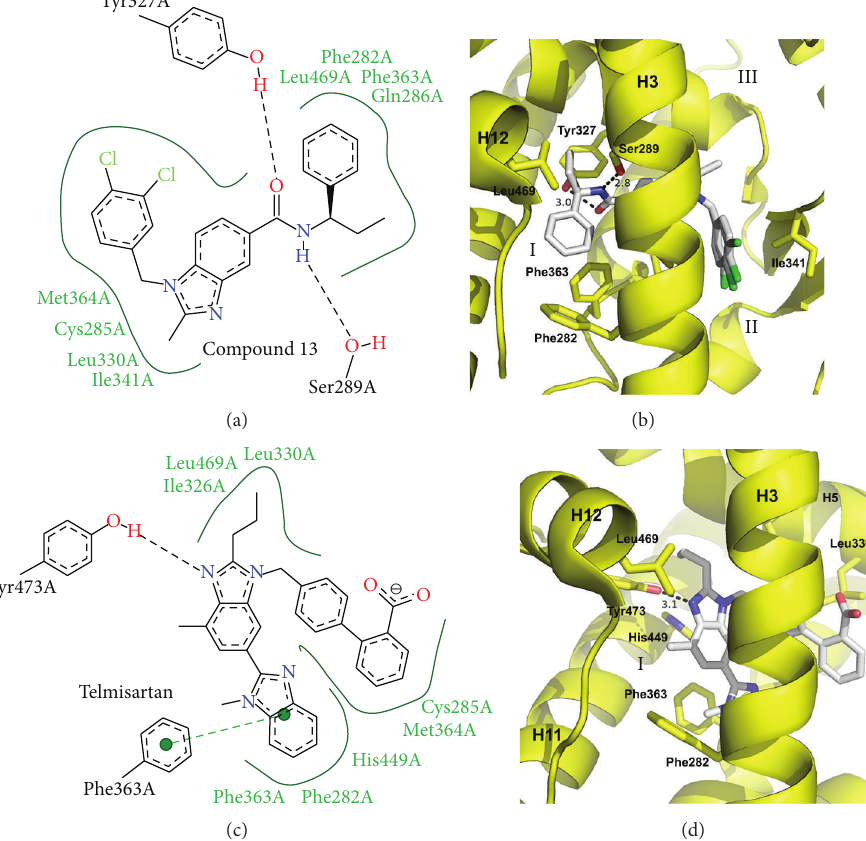
Figure 4: Crystal structures of benzimidazole containing PPAR 𝛾 partial agonists. (a) Poseview map of Compound 13. (b) Crystal structure of Compound 13 bound to the PPAR 𝛾 ligand binding domain. PDB: 3S9S [52]. (c) Poseview map of Telmisartan. (d) Crystal structure of Telmisartan bound to the PPAR 𝛾 ligand binding domain. PDB: 3VN2 [53]. The branches of the ligand binding pocket have been labelled with Roman